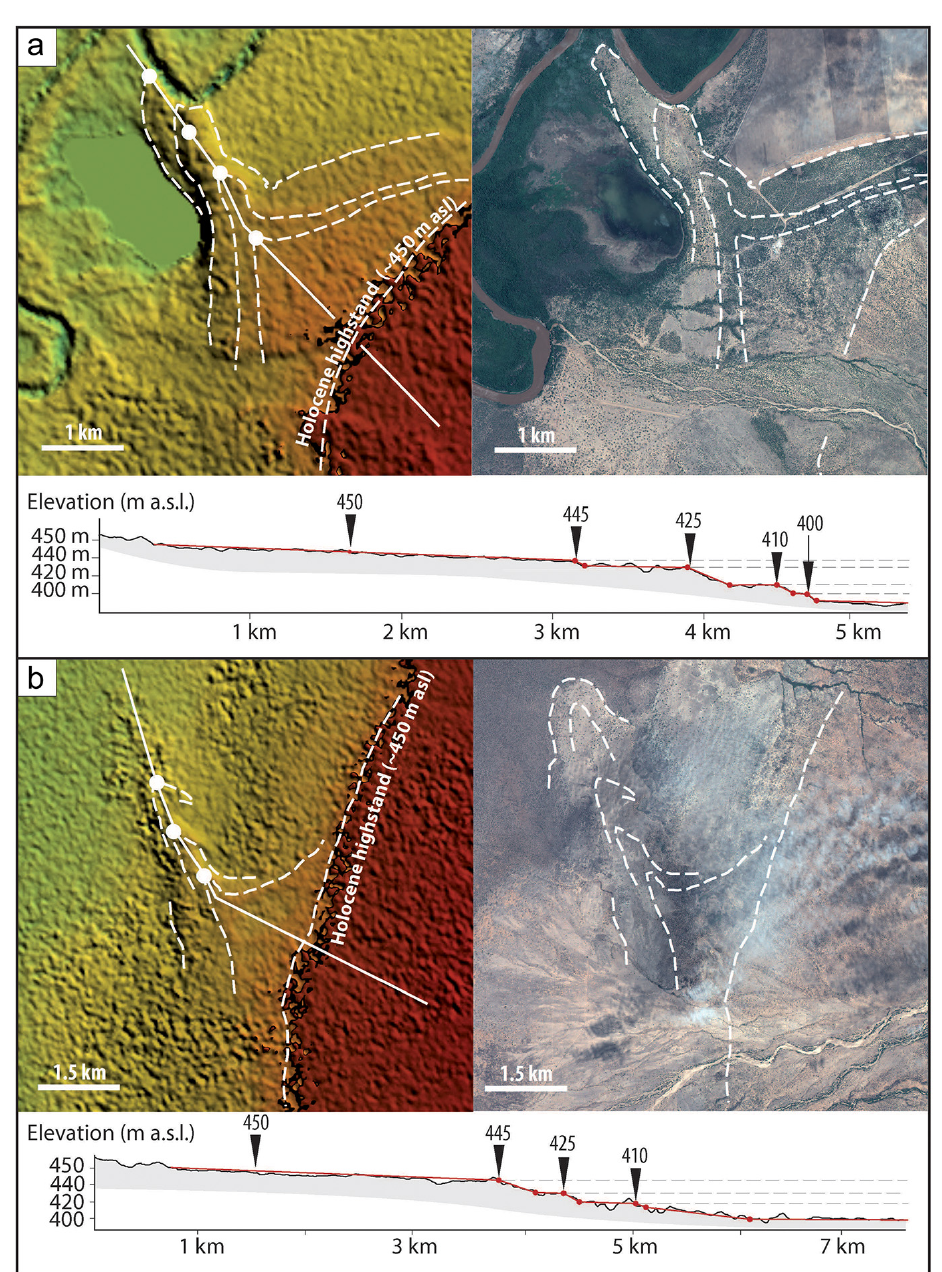
Figure 5. Fossil spits along the eastern Omo River valley (for location see Figure1b) from SRTM 1 (left panel) and from PLEIADES images (right panel). The fossil spits are outlined by dashed white lines. They display plateaus interrupted at similar elevations to those of the Turkwel